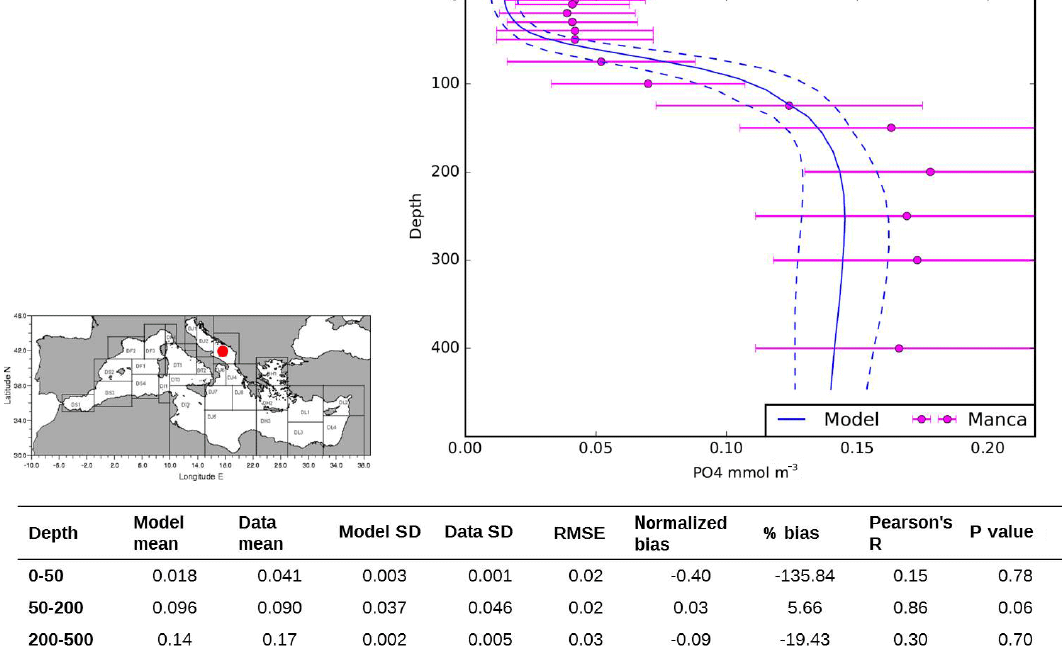
Figure A4. Annually averaged PO 4 vertical profile in the south Adriatic sub-basin (see map and Manca et al., 2004) and statistical indicators over different depth. Model values are shown with the blue line (2005 average, Ntot simulation from Richon et al., 2017) and measured values from Manca et al. (2004) are in pink. Horizontal bars and dashed lines indicate the spatial SD of observations and model results